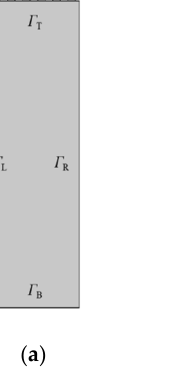
Figure 2. Schematic diagram of structure: ( a ) schematic diagram of the two-dimensional model; ( b ) schematic diagram of grid division.